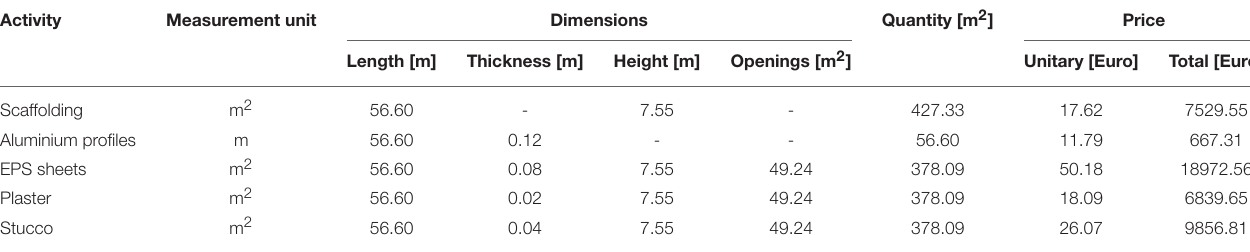
TABLE 6 | Costs of the insulation of